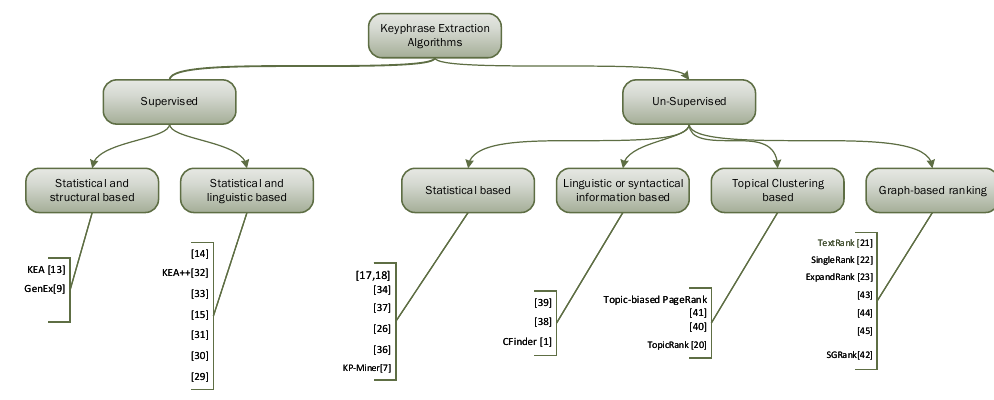
Figure 1. Classification of supervised and unsupervised algorithms for keyphrase